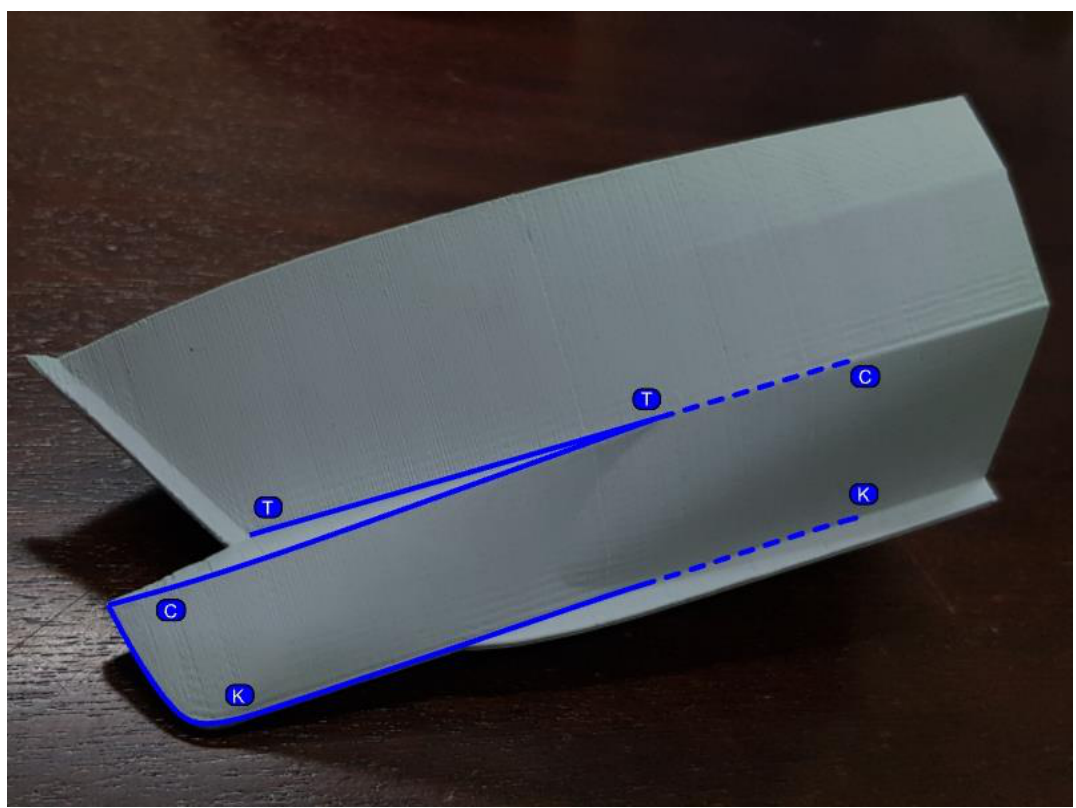
Figure 5. Example of curves; T curve over the hull.